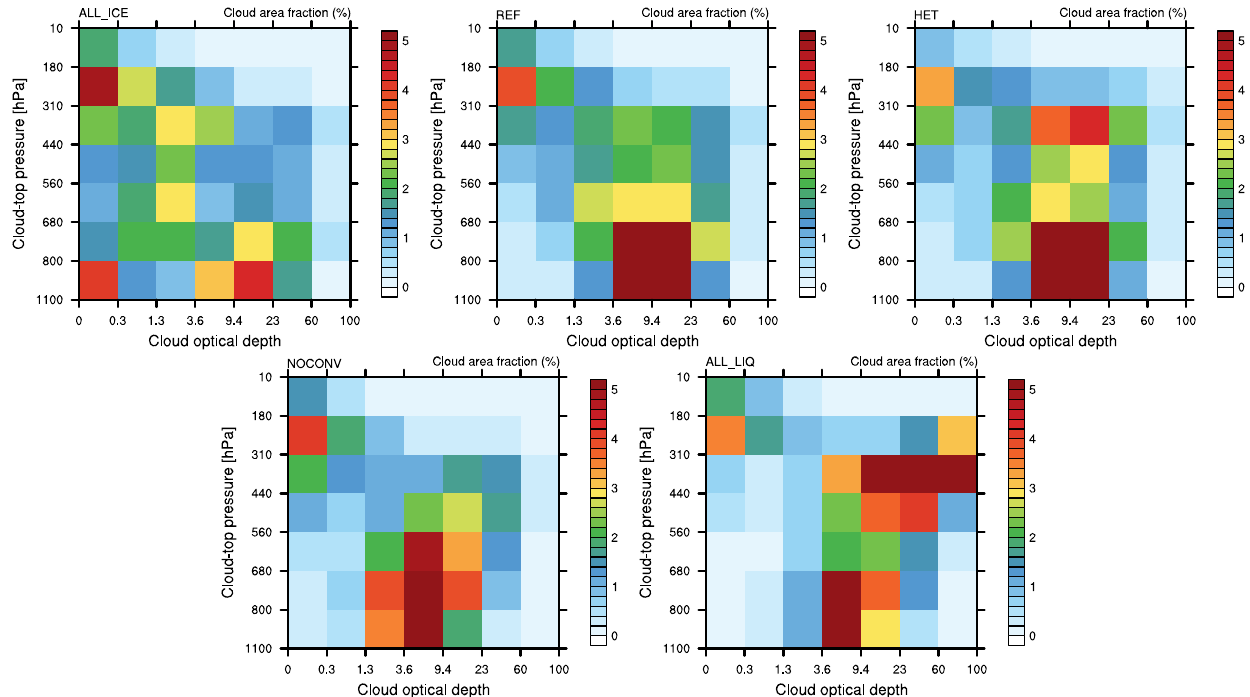
Figure 4. Distribution of cloud fraction in the extratropics ( > 40 ◦ S and N) as a function of cloud optical depth and cloud-top pressure between the 2 × CO 2 and the 1 × CO 2 climate in simulations ALL_ICE, HET, REF, NOCONV, and ALL_LIQ from the last 25 years of the MLO simulations described in Table